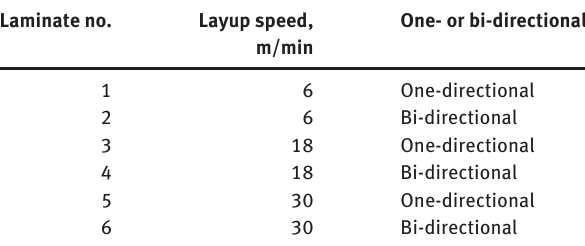
Table 1 Layup accuracy trials.